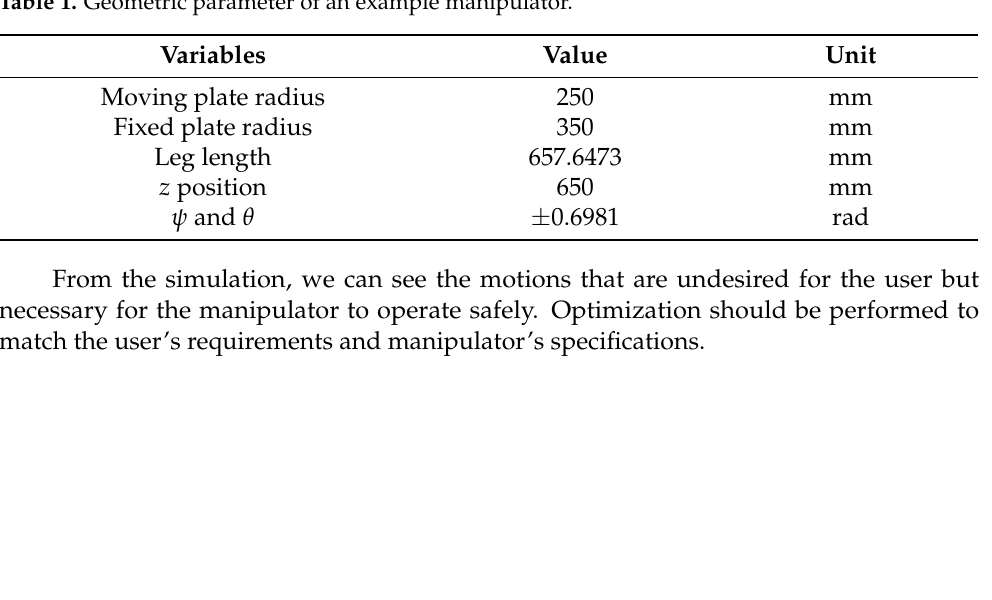
Table 1. Geometric parameter of an example